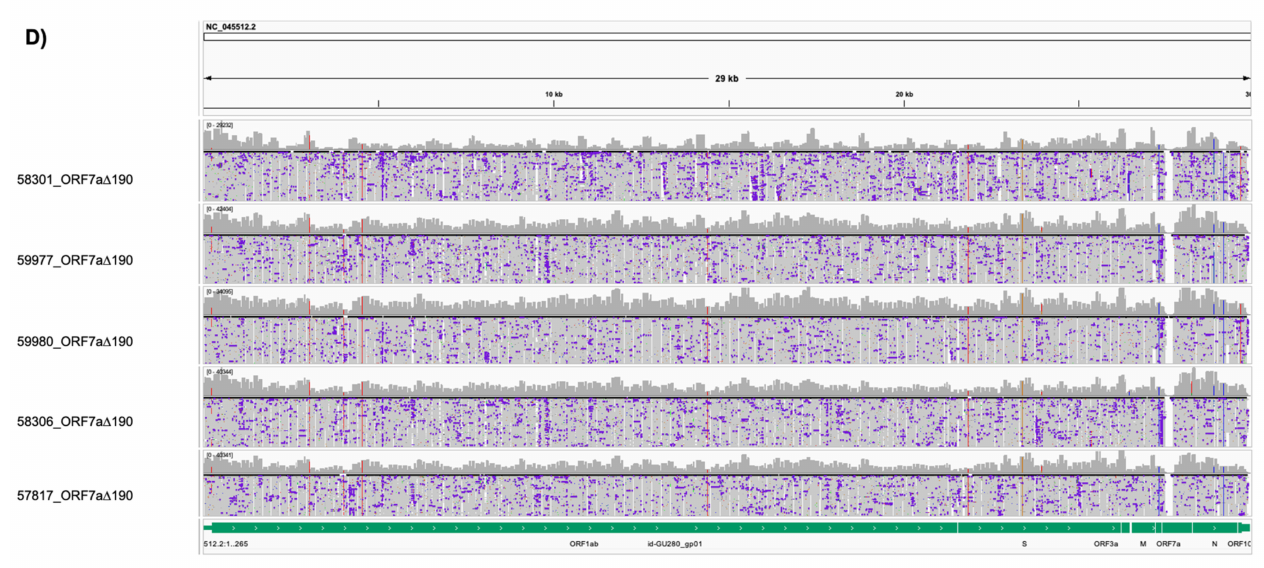
Figure 1. A 190-nucleotide deletion in the ORF7a gene (ORF7a ∆ 190) and impact on the protein structure. ( A ) Top: Amplification and confirmation of 190-nt deletions amongst family members using primers forward (M_27145 F) and reverse (ORF8_28003R) (see scheme) indicating the po- sitions on the SARS-CoV-2 genome. Bottom: ORF7a 190-nt deletions visualization in five family members on agarose gel (2%) stained with ethidium bromide revealed that the PCR products target the ORF7a gene. 100bp Molecular Weight Marker (lane M), 11785_ORF7a_wt, 58301_ORF7a_ ∆ 190, 59977_ORF7a_ ∆ 190, 59980_ORF7a_ ∆ 190, 58306_ORF7a ∆ 190, 57817_ORF7a ∆ 190. ( B ) Electrophero- grams from Sanger sequencing of the ORF7a PCR products from samples with 190-nt deletions: 59980, 59977, 58306, 58301 and 57817, the wt (without 190-nt deletion) 11785 aligned to the SARS-CoV-2 reference sequence (NCBI RefSeq SARS-CoV-2 genome sequence, NC_045512.2). ( C ) ORF7a deletions and impact on the protein structure. Left: Multiple sequence alignment of the reported ORF7a deletion (58301_ORF7a_ ∆ 190), and the corresponding sequences for SARS-CoV-2 and SARS-CoV ectodomain structures (PDB IDs: 7ci3 and 1xak, respectively) in respect of the reference sequence (NCBI RefSeq for SARS-CoV-2 ORF7a protein, YP_009724395.1). Identical residues are shaded in red; mutations from SARS-CoV to SARS-CoV-2 are colored in black and ORF7a altered residues are colored in grey. The labeled arrows indicate the secondary structure observed on the crystal struc- tures. The different protein domains are indicated by the color bars below the alignment: N-terminal signaling region (residues 1–15, blue), Ig-like ectodomain (residues 16–96, yellow), hydrophobic transmembrane domain (residues 97–116, green) and ER retention motif (residues 117–121, brown). Right: Ribbon representation of the tridimensional SARS-CoV-2 ORF7a structure. The full-length structure of the ectodomain is colored in cyan. The β -strands are assigned numerically from the N-terminus to the C-terminus, corresponding to the alignment above. The deletion presented by the 58301_ORF7a_ ∆ 190 sample is colored in magenta, in both structures, covering a significant portion of the protein ectodomain, comprising the β sheets 3 to 7, the full transmembrane and ER retention motif. ( D ) Sars-CoV-2 whole genome sequencing of samples belonging to the five family members mapped to the reference sequence, aligned and visualized on IGV viewer. ORF7a region displays gaps evidencing the 190-nt deletion in all five